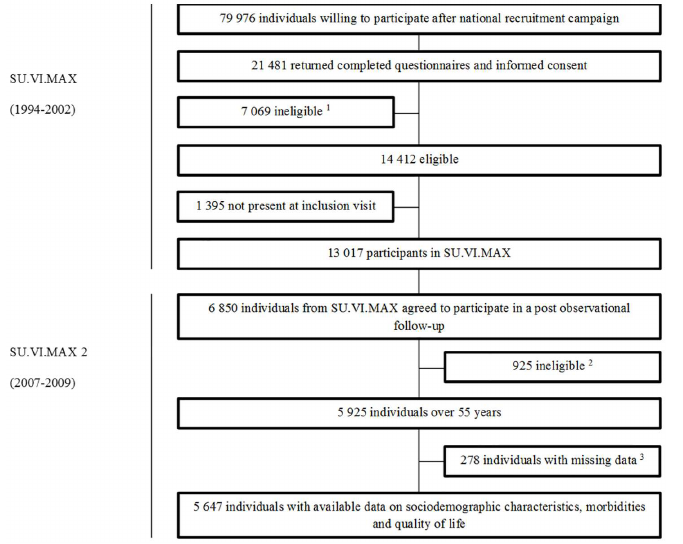
Fig 1. Enrollment and flow of participants in the Supple´mentation en Vitamines et Mine´raux Antioxydants (SU.VI.MAX) study and follow-up (SU.VI.MAX 2). 1 Doesn’t met eligibilitycriteria. 2 Under 55 years. 3 Missing data about sociodemographic characteristics, morbidities and qualityof